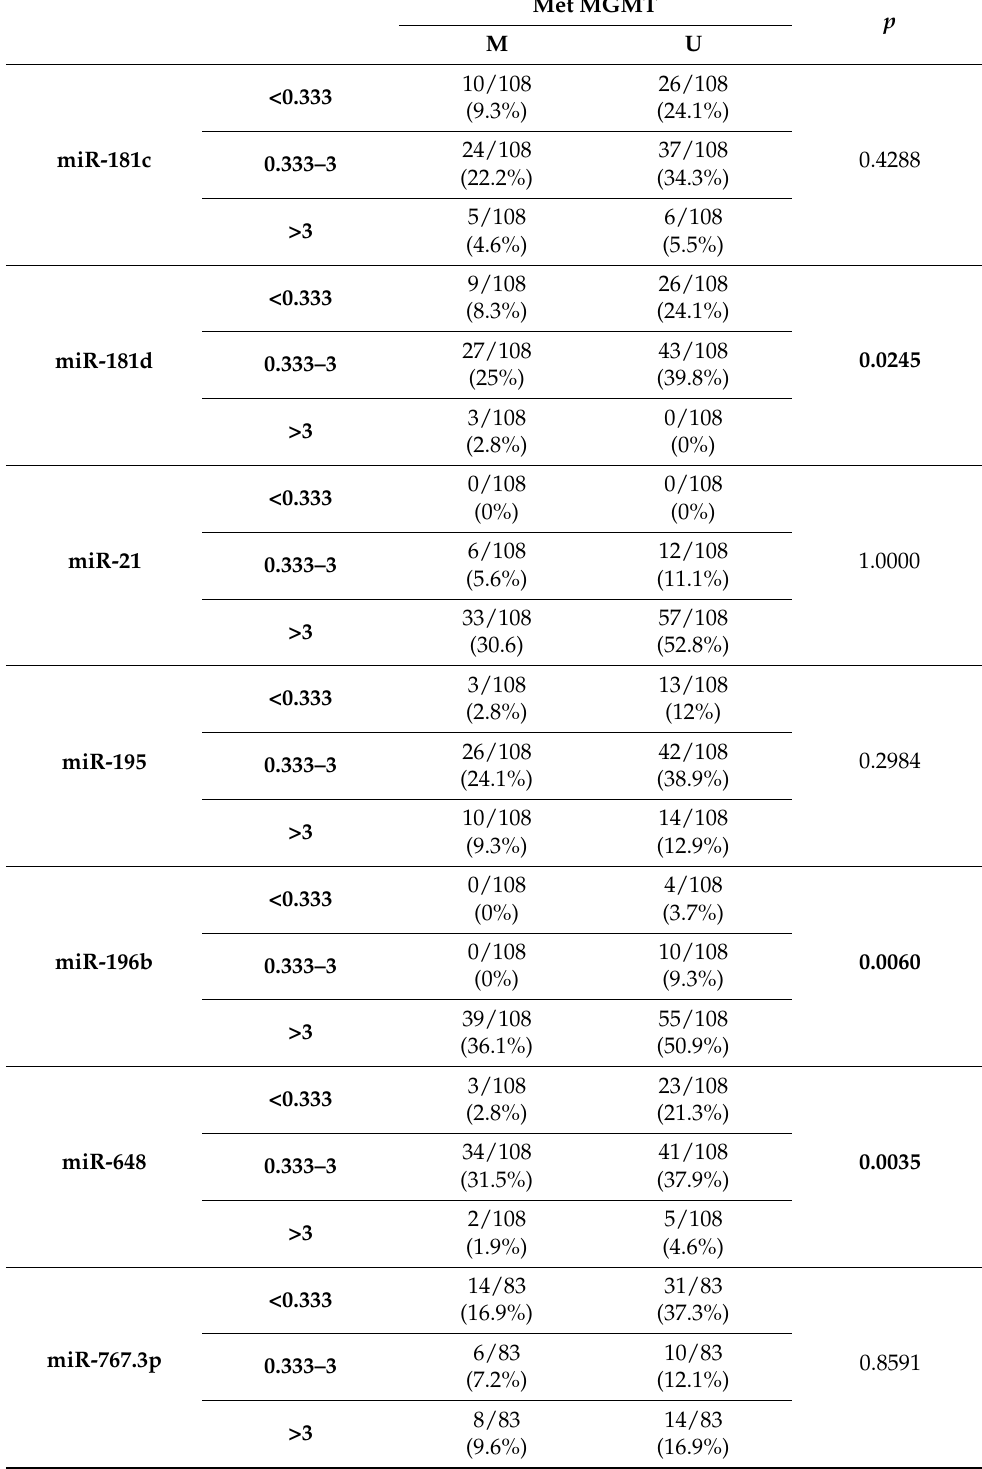
Table 4. MGMT methylation and miRNA bivariate